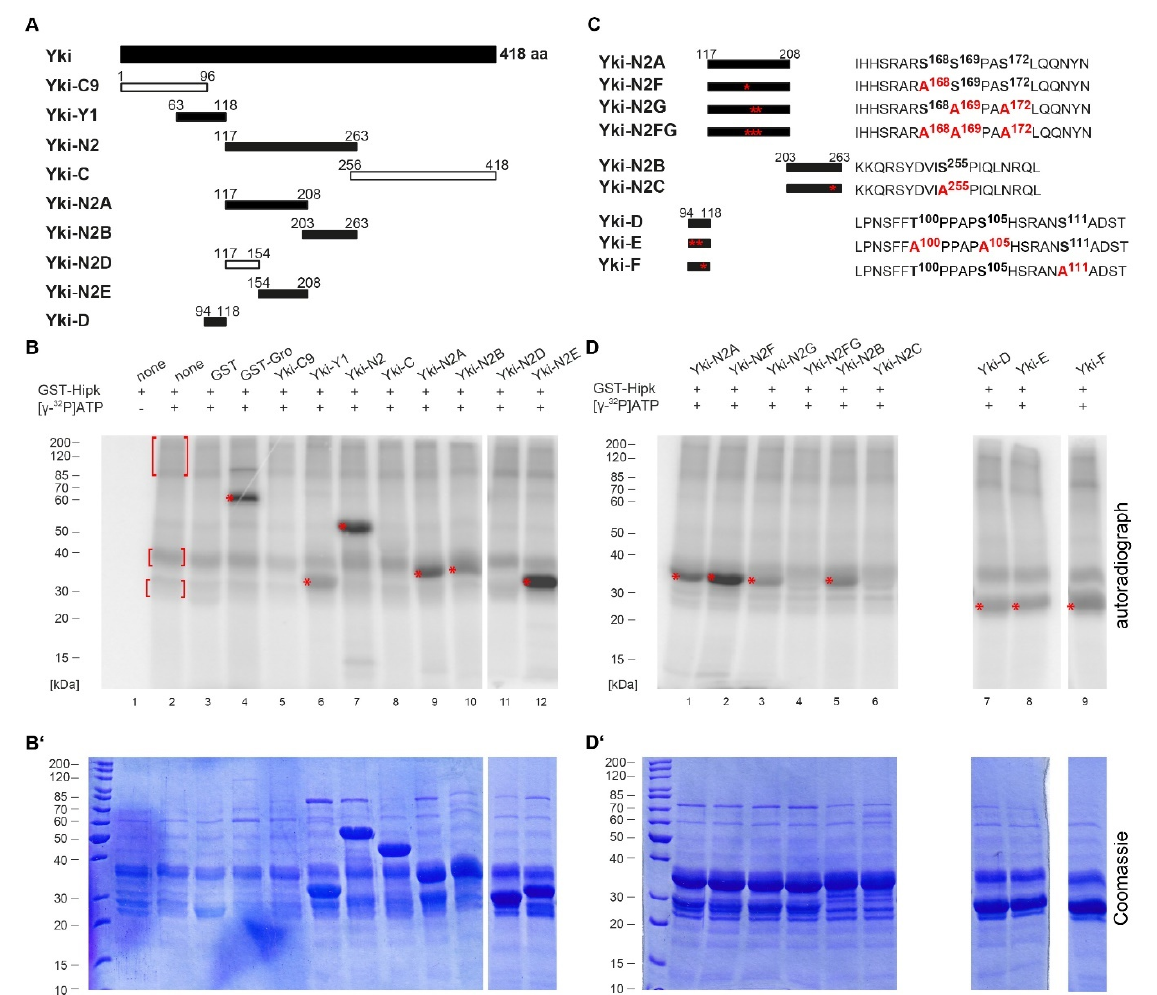
Figure 1. Homeodomain-interacting protein kinase (Hipk) phosphorylates Yorkie (Yki) in vitro. ( A ) Schematic view of the full-length protein Yki with 418 amino acids (aa). Positions and sizes of different constructs of Yki that were purified and analysed by phosphorylation assay are shown below (Yki-C9, -Y1, -N2, -C, -N2A, -N2B, -N2D, -N2E and -D). Numbers indicate terminal amino acid positions of the constructs. Phosphorylated constructs are represented as black and non- phosphorylated constructs as white bars. ( B ) Autoradiograph after in vitro phosphorylation assay of the purified Yki constructs. Each protein contained a glutathione S-transferase (GST)-tag and was incubated with full-length GST-Hipk and radioactively labelled adenosine triphosphate ([ γ - 32 P]ATP). GST-Hipk and GST protein alone served as negative controls (lanes 2 and 3), and GST-Groucho (Gro), a confirmed substrate of Hipk, as a positive control (lane 4). Autophosphorylation of Hipk led to a background signal (see marked within red brackets), which was subtracted in the following lanes. Signals from phosphorylated proteins are marked with red asterisks. ( B’ ) Loading control according to (B): original 12%-SDS (sodium dodecyl sulfate)-polyacrylamide gel electrophoresis (PAGE) for the phosphorylation assay, Coomassie-stained. ( C ) Schematic view of the mutated derivatives of Yki-N2A (Yki-N2F, -N2G and -N2FG), Yki-N2B (Yki-N2C) and Yki-D (Yki-E and Yki-F) with a section of the amino acid sequence of the corresponding fragment on the right. Potentially phosphorylated amino acid residues that were affected by the mutational analysis are accentuated in bold; the respective mutated sites are shown in red. ( D ) Autoradiograph after in vitro phosphorylation assay of the mutated Yki constructs. Signals from phosphorylated proteins are marked with red asterisks. ( D’ ) Loading control according to (D): original 12%-SDS-PAGE for the phosphorylation assay, Coomassie-stained.